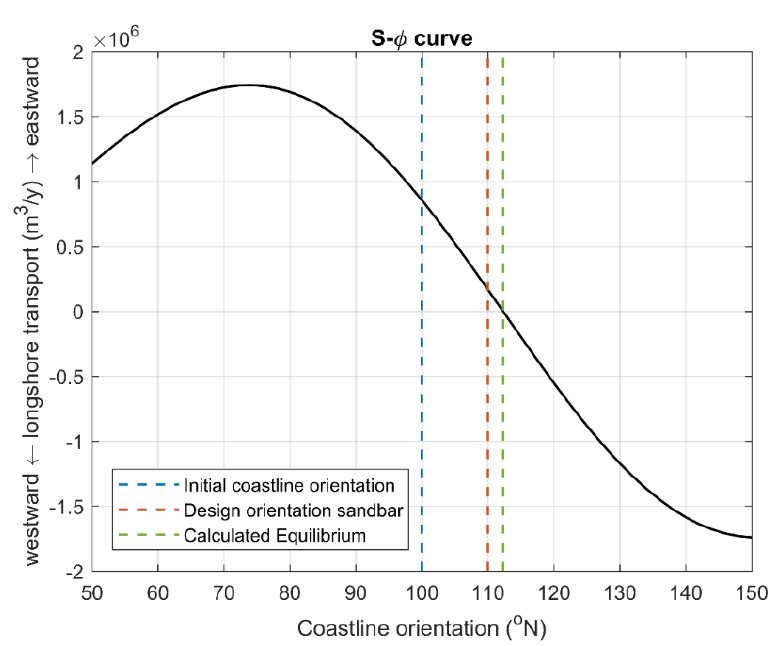
Figure 7. Calculated S-φ curve at the project site, Lekki, Nigeria.